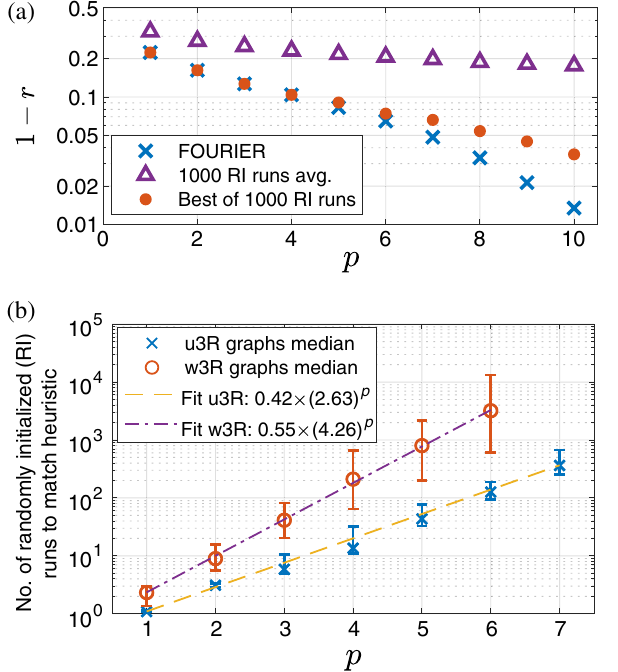
FIG. 3. (a) Comparison between our FOURIER heuristic and the RI approach for optimizing the QAOA, on an example instance of a 16-vertex w4R graph. The figure of merit 1 − r , where r is the approximation ratio, is plotted as a function of QAOA level p on a log-linear scale. The RI points are obtained by optimizing from 1000 randomly generated initial parameters, averaged over ten such realizations. (b) The median number of randomly initialized optimization runs needed to obtain an approximation ratio as good as our FOURIER heuristic, for 40 instances of 16-vertex u3R and w3R graphs. A log-linear scale is used, and exponential curves are fitted to the results. Error bars are 5th and 95th